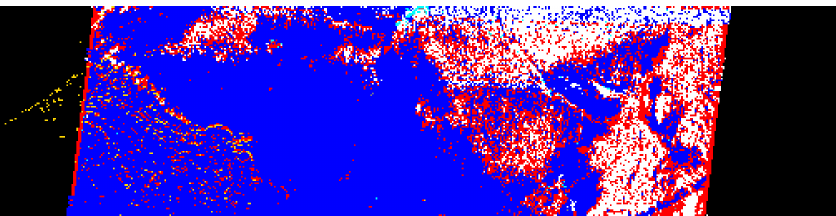
Figure 12. Map of the MISR RCCM for Path 168, Orbit 2111, Block 110 and camera BA. This map exhibits the intermediary product obtained at the end of the processing step involving values at the same location in the neighboring cameras (Sect. 3.3) and before investigating the values of immediate neighbors in the same camera (Sect. 3.4). Note also the presence of a straight line of missing values near the western edge of the Block, which is correctly replaced in the final corrected RCCM product shown in Fig. 11b. Linear dimensions are as described in the caption of Fig. 3, while color coding is identical to that indicated in Fig.